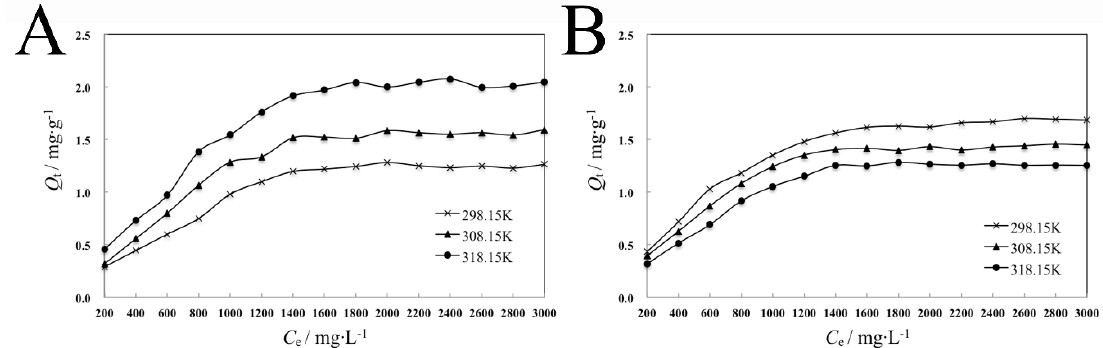
Figure 5. Adsorption isotherms of dispersant 2700 onto pyraclostrobin crystal II particle ( A ) and pyraclostrobin crystal IV particle ( B ) at different temperatures.